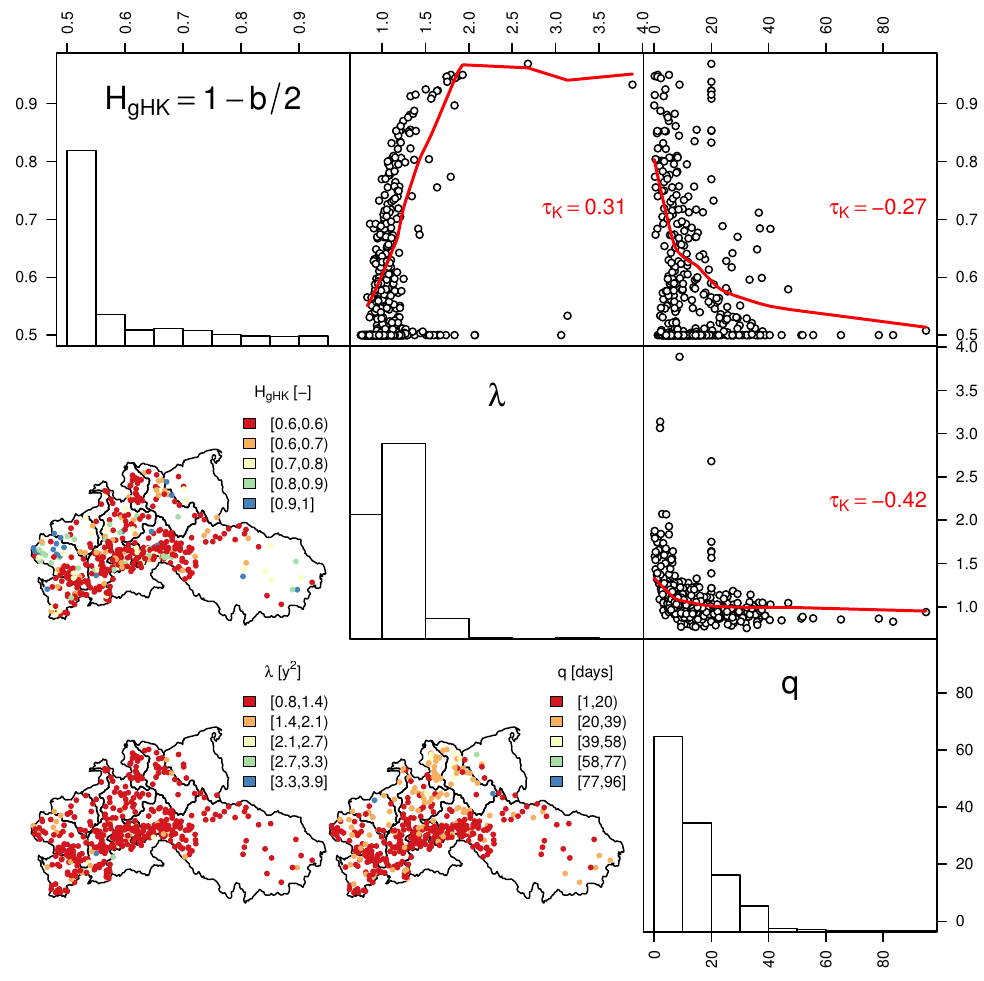
Figure 9. Estimates of gHK parameters H = 1 − b /2, λ , and q : Histograms (main diagonal of panels); pairwise scatter plots, LOESS smoothing curves (red lines), and τ K values (upper triangular matrix of panels); and spatial distribution (lower triangular matrix of